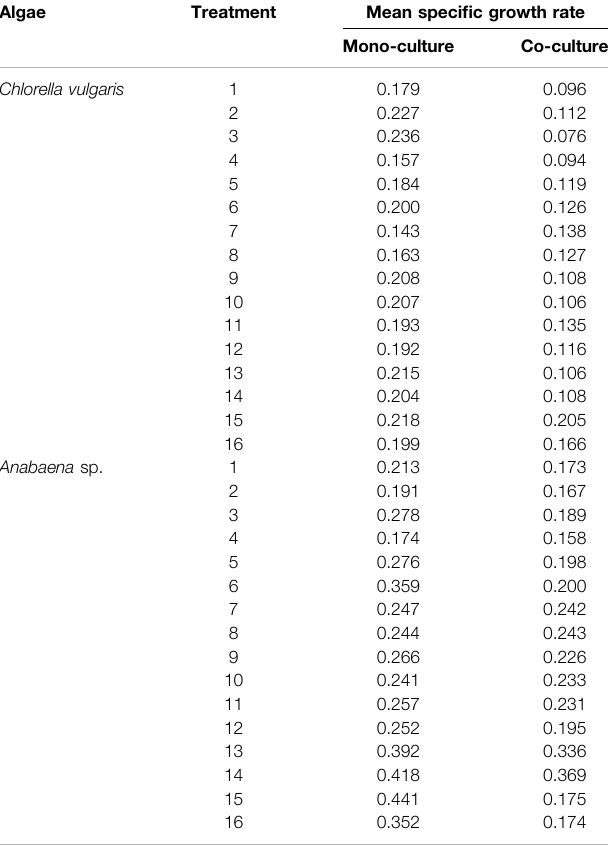
TABLE 3 | Mean speci fi c growth rate ( μ ) of Chlorella vulgaris and Anabaena sp. strain PCC at different conditions.